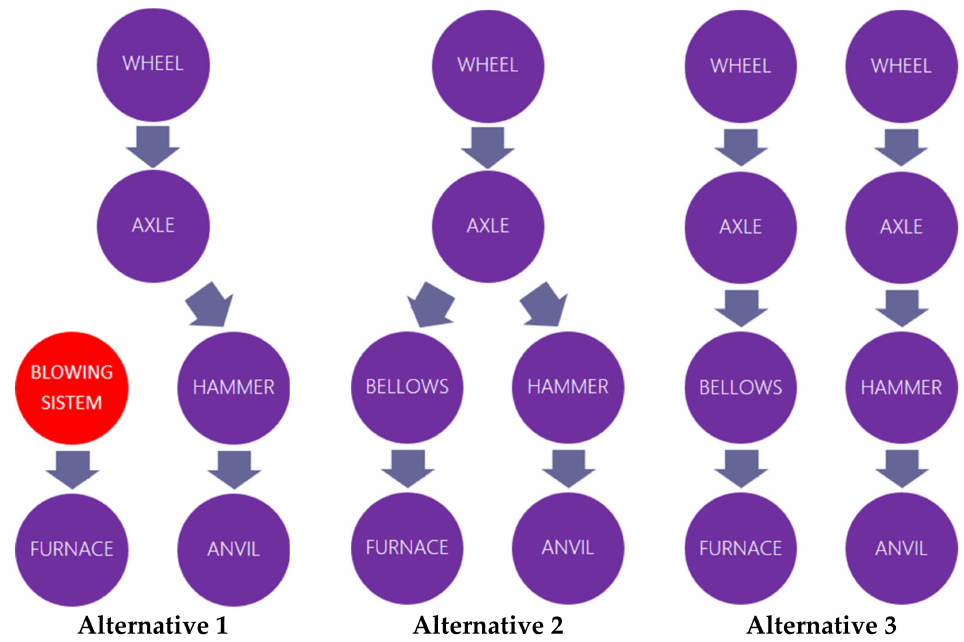
Figure 8. Diagrams of the operation of a hydraulic forge. Source: own